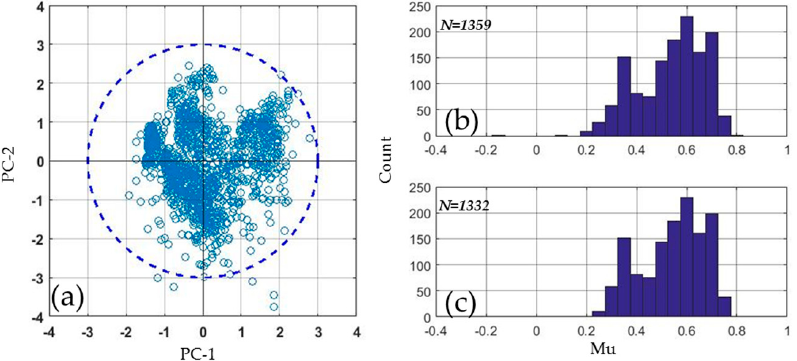
Figure 3. Outlier detection module results: ( a ) PC-1/PC-2 z-score scatter plot of the spectral data with a ±3 confidence circle; ( b ) histogram of friction value before outlier elimination; ( c ) histogram of friction value after outlier elimination.